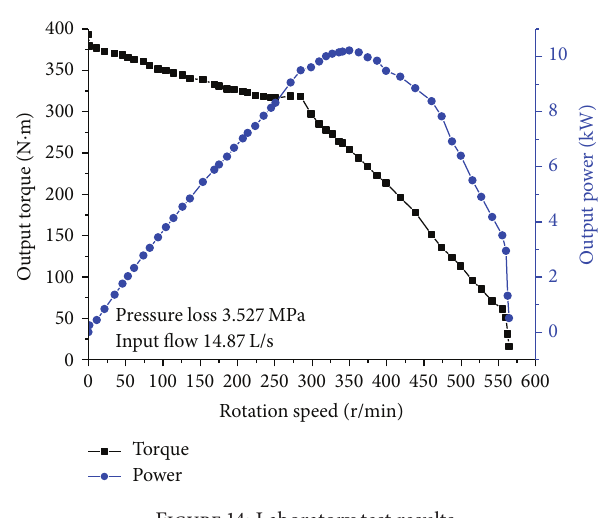
Figure 14: Laboratory test